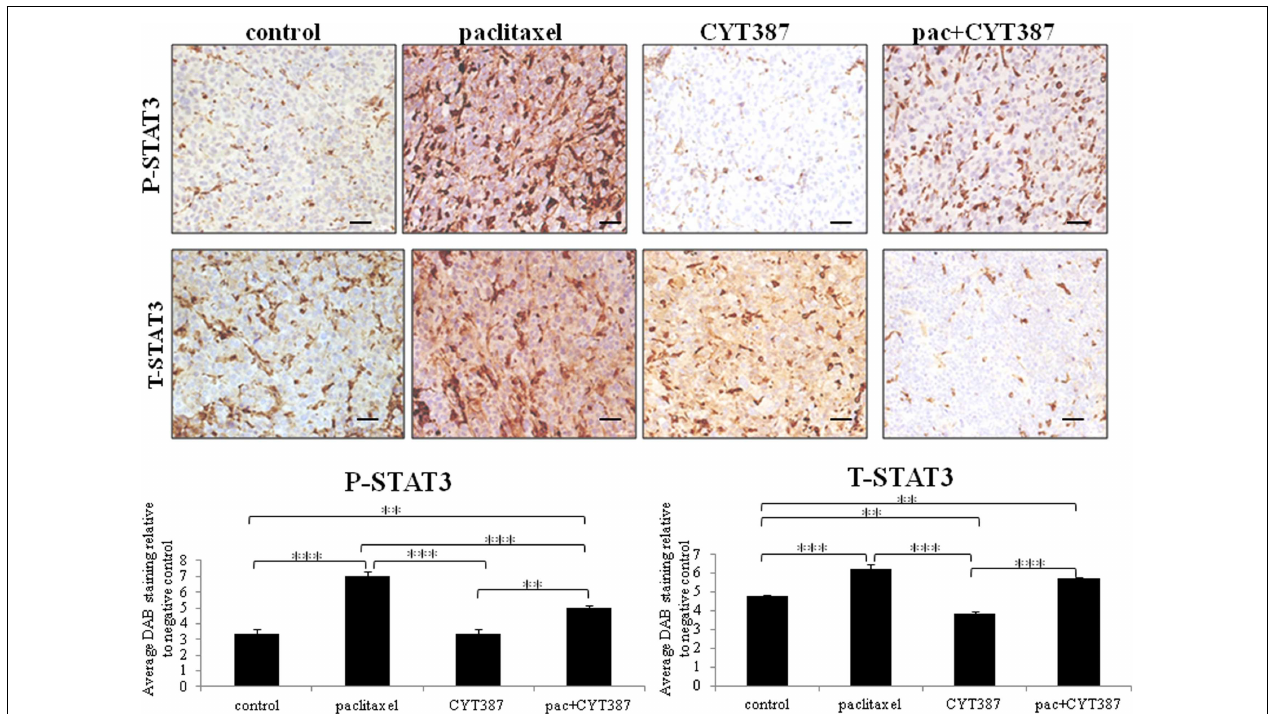
Magnification 200 × , scale bar = 10 µ M. Average DAB intensity and proportion of staining of P-STAT3 orT-STAT3 in xenografts was standardized to a negative control.The quantification was derived from the staining of five independent xenografts in each group. Significant intergroup variations are indicted by ** p < 0.01 and *** p <